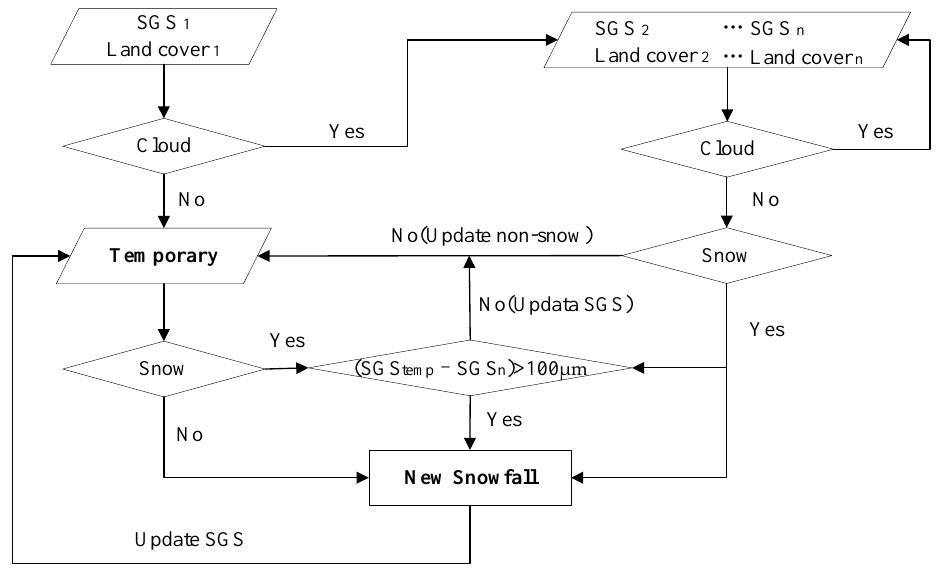
Figure 4. Flowchart for snowfall detection.